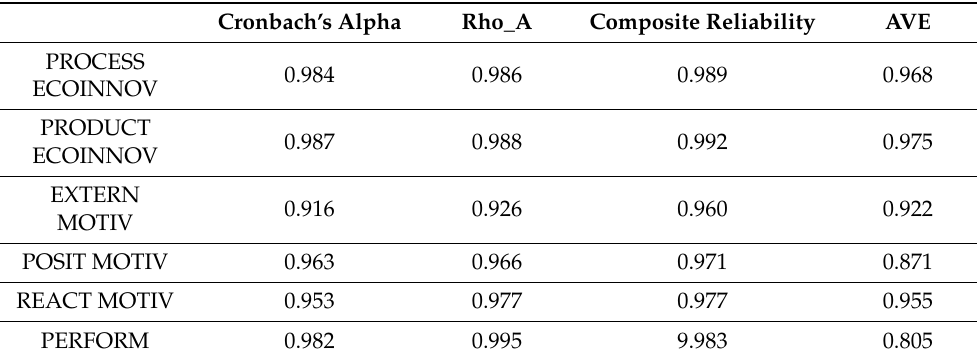
Table 2. Convergent validity.